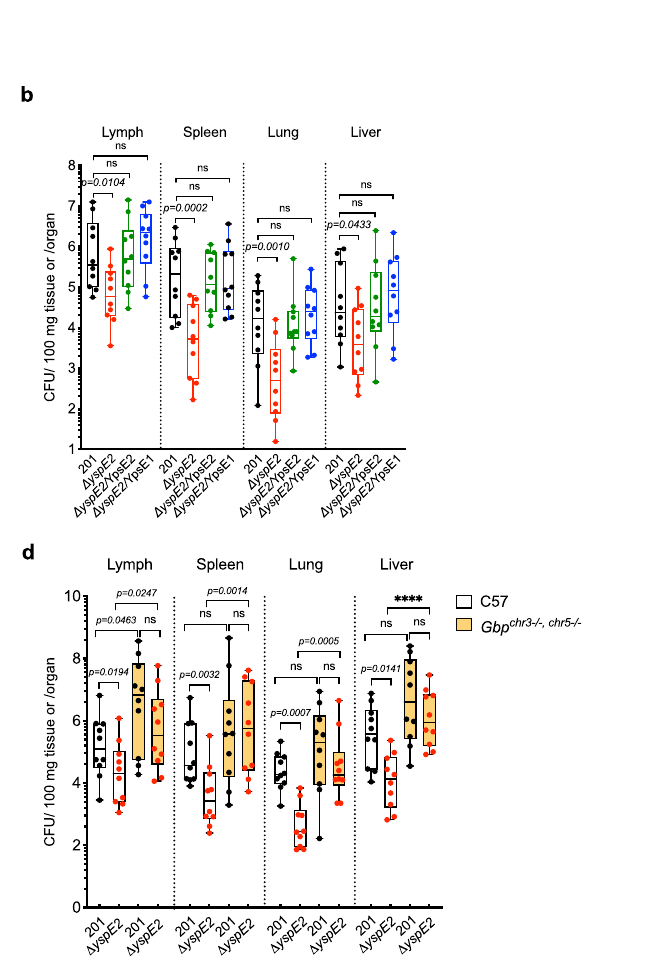
Fig.7| YspE2promotesthesurvivalof Y.pestis inmacrophageandinhibitsthe in fl ammasome activation in an E3 ligase activity dependent manner. The per- centageofintracellularsurvivalof Y.pestis 201and Δ yspE2 inBMDMsisolatedform C57BL/6J( a , b )or Gbp chr3 − / − ,chr5 − / − mice( d , e ).BMDMsweredirectlyinfectedwiththe Y.pestis 201or Δ yspE2 ( a , d ),orprimedwithIFN- γ priortoinfection( b , e ).Theliving